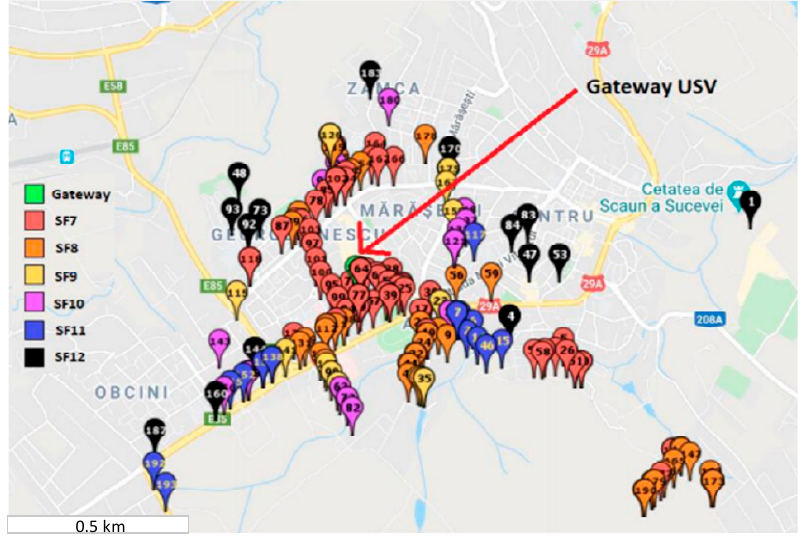
Figure 7. LoRaWAN coverage map measurement.